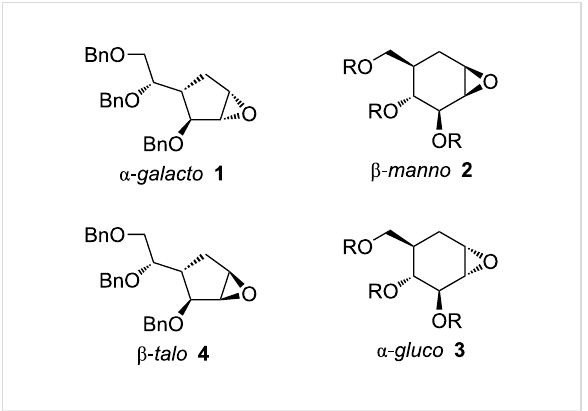
Figure 1: Structures of carbapyranose and carbafuranose 1,2-epox- ides.